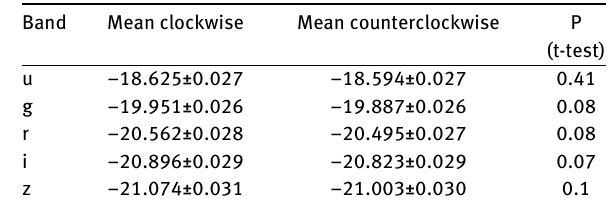
Table 10. Absolute exponential magnitude of clockwise and counterclockwise SDSS galaxies with spectra in the RA range of (120 ∘ , 210 ∘ ).